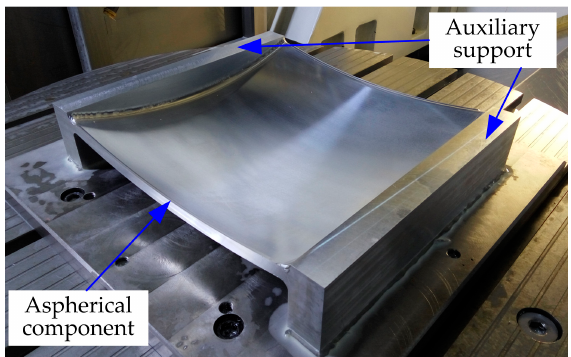
Figure 9. Machined aspherical component from the HSC 75 Linear.